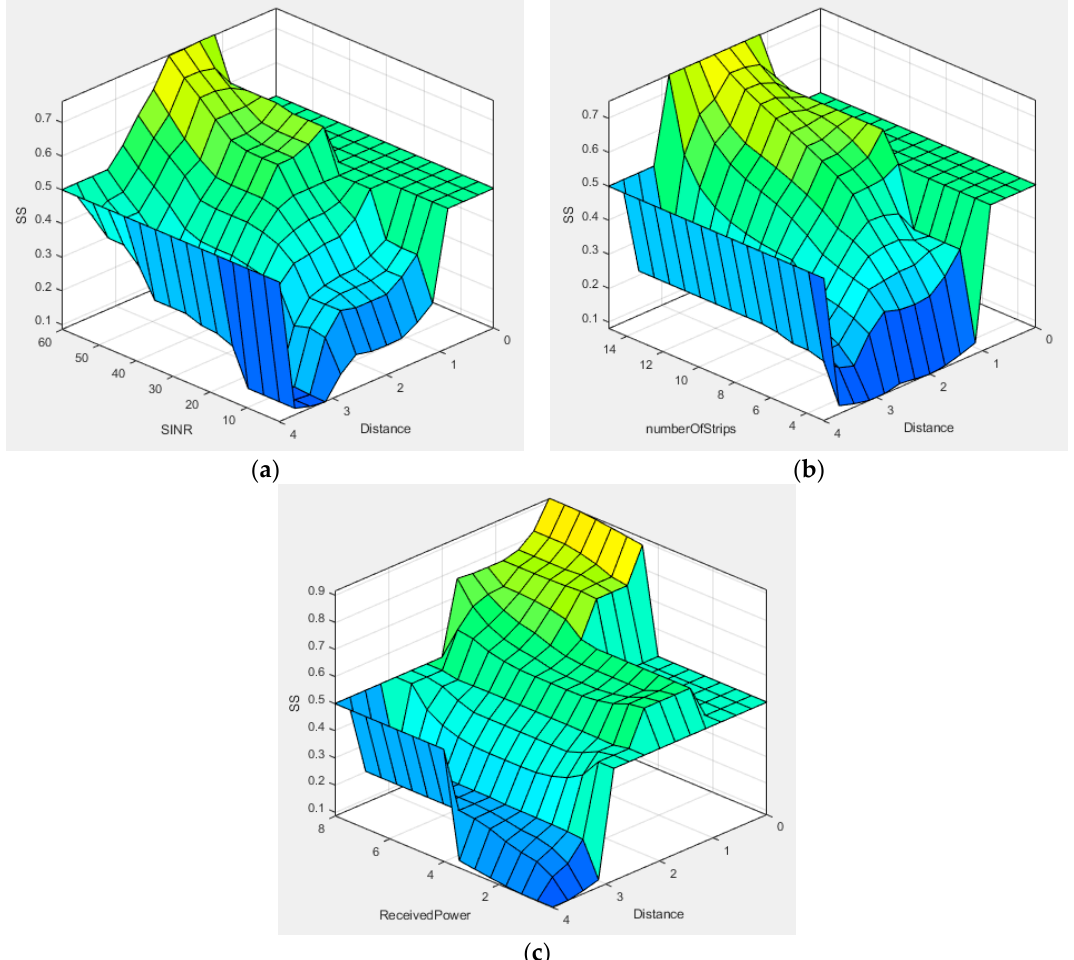
Figure 6. Variation of the selection score (SS) with distance and ( a ) SNIR, ( b ) number of strips, and ( c ) instantaneous received